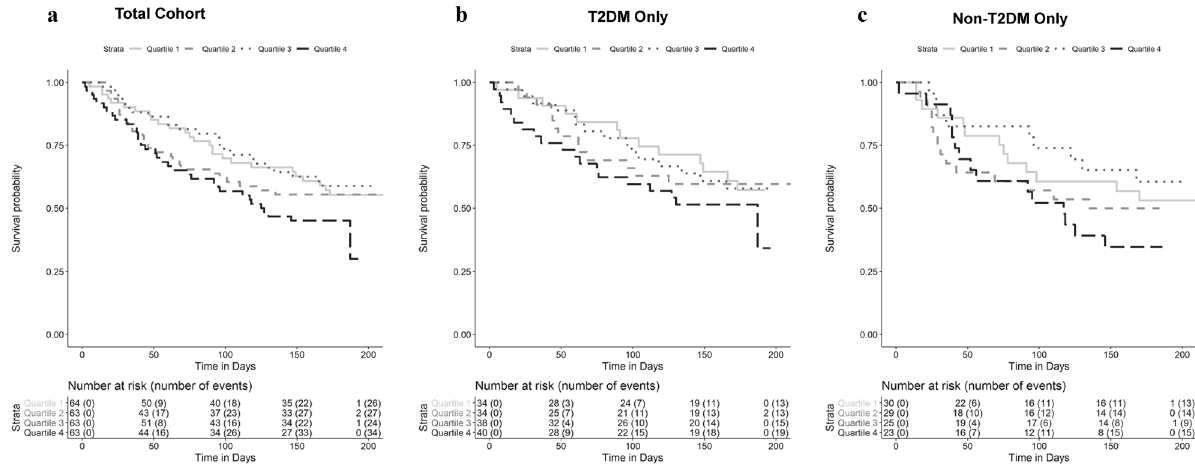
Figure 3. Time to death or heart failure hospitalization by quartile of factor 4 level. Kaplan–Meier curves stratified by quartiles of factor 4 levels in the overall cohort ( a ) and individuals with ( b ) and without ( c ) T2DM. The numbers below each graph represent the number of individuals at risk and the cumulative incidence of events at each time point in